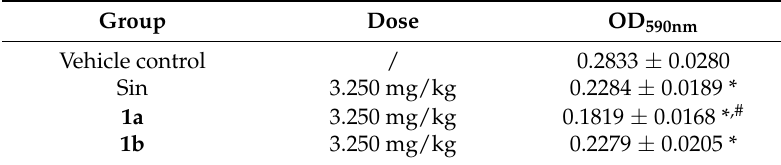
Table 3. Inhibition of acetic acid-induced increases in vascular